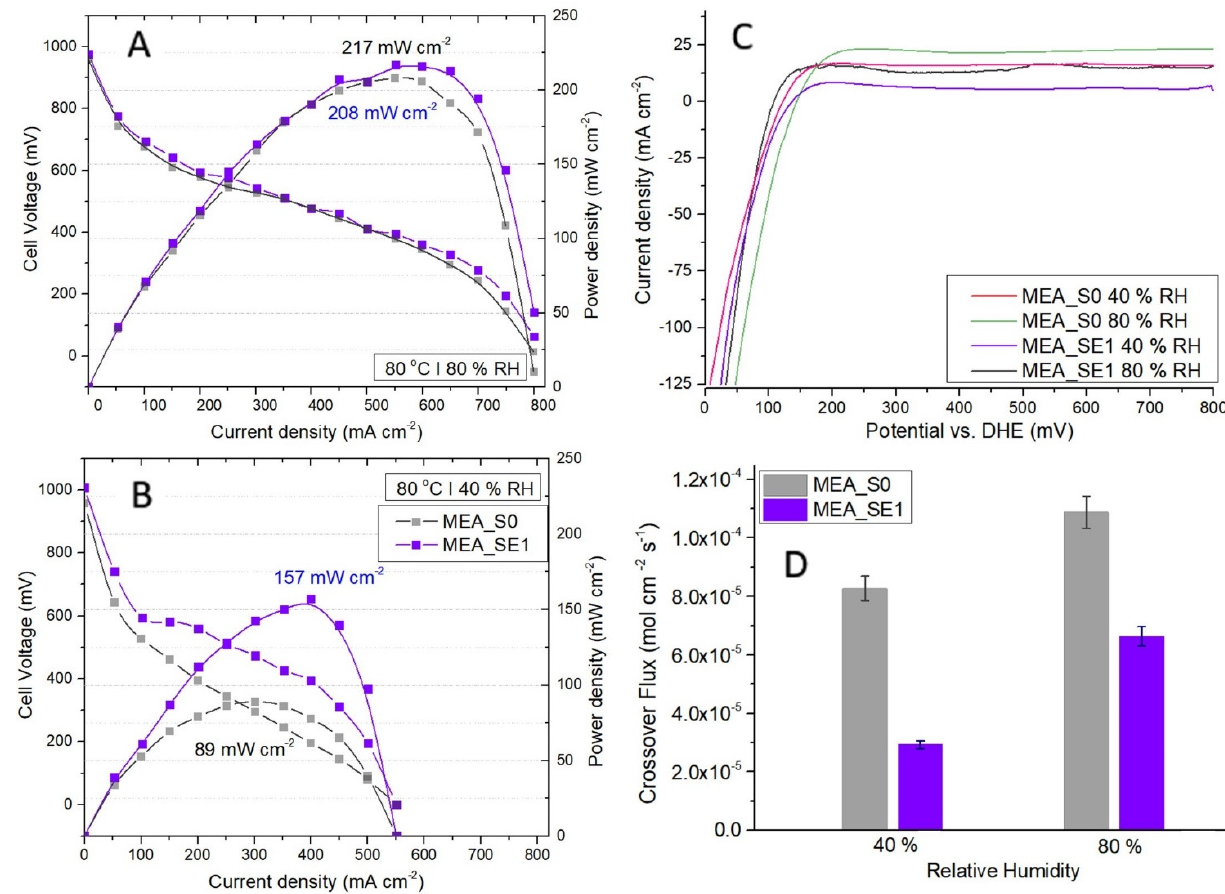
Figure 8. Polarization curves of comparative I–V and power density profiles between the SE1-based and reference MEAs at 80 °C and 80% relative humidity ( A ), respectively, at 80 °C and 40% relative humidity ( B ). Peak power densities given next to the corresponding profiles. In situ polarization testing was performed at 70 kPa of overall pressure in galvanostatic mode by controlling the current and applying fixed flow rates of 200 SCCM of hydrogen at the anode and 800 SCCM of air at the cathode. ( C ) Hydrogen crossover testing by in situ linear sweep voltammetry for S0 and SE1-based MEA at 80 °C and relative humidity values of 40% and 80%; ( D ) hydrogen crossover comparative results for the SE1-based and the reference MEAs over all testing conditions.